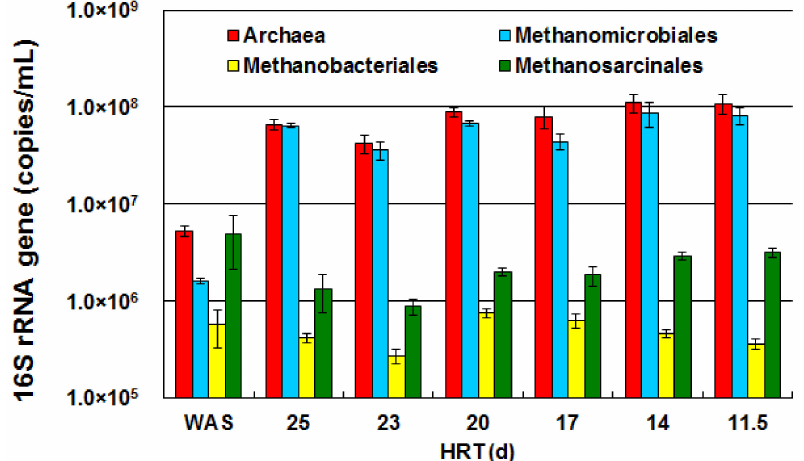
Figure 4. Real-time polymerase chain reaction (PCR) quantification of the archaeal 16S rRNA genes at the domain and the order levels. Methanococcales was not